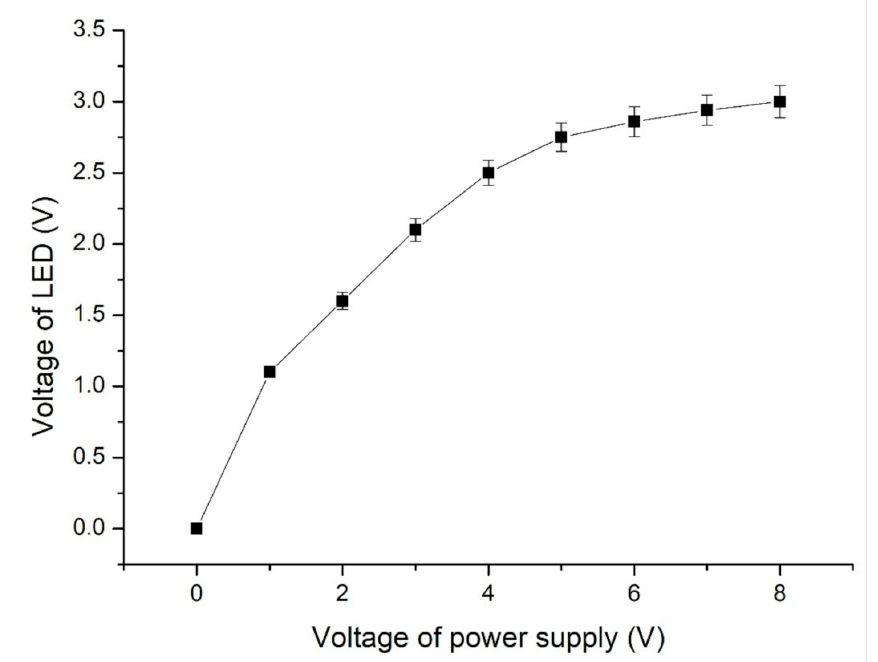
Figure 6. Electric voltages of the LED with the liquid conductor at various power supply electric